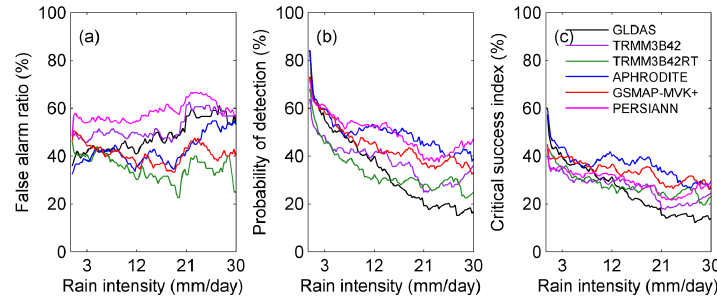
Figure 8. False alarm ratio, probability of detection, and critical success index for the six precipitation